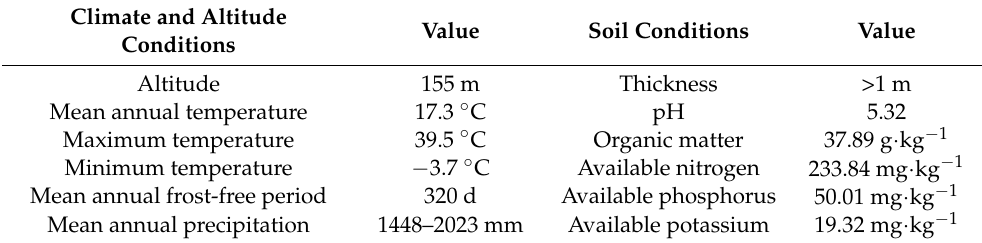
Table 1. Conditions of climate, altitude, and soil of the regenerated D. latiflorus planting